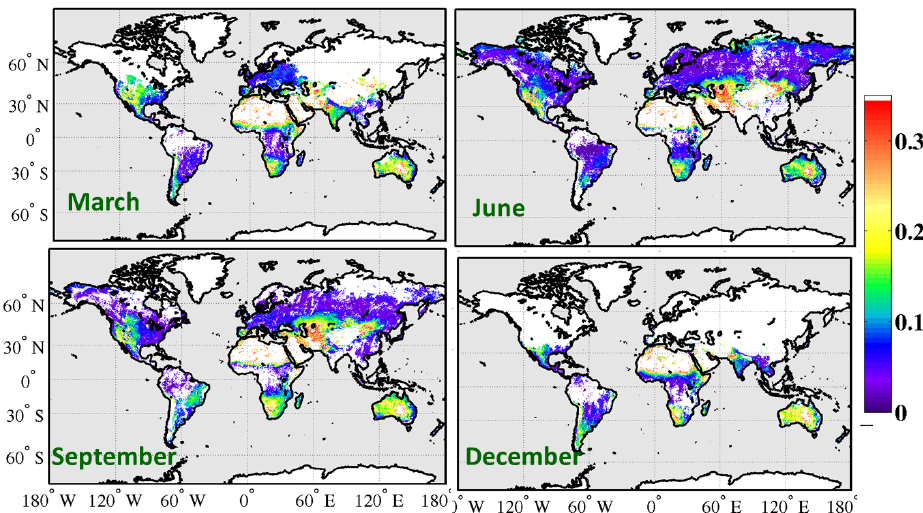
Figure 4. Monthly aggregated surface reflectances at 659nm retrieved from AATSR with ADV for March, June, September and December